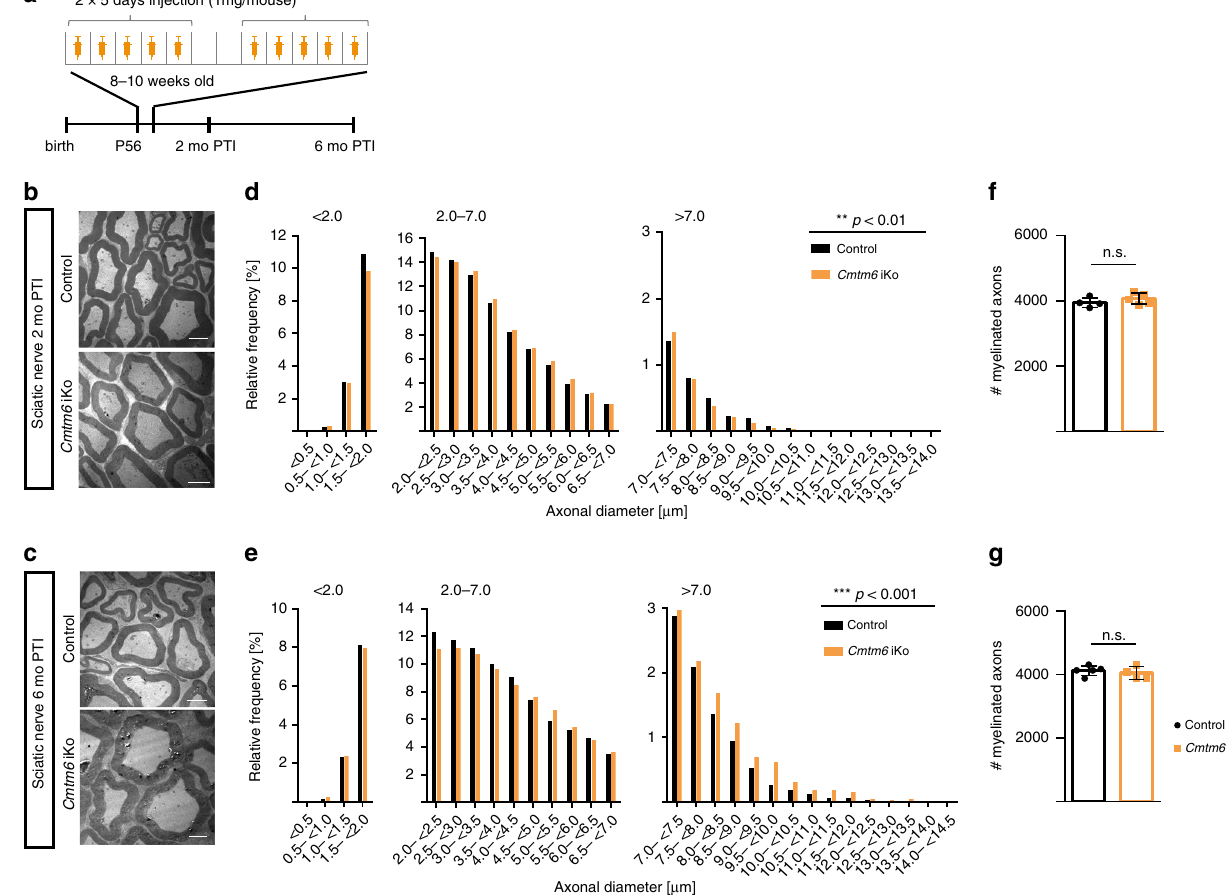
Fig. 4 Adult deletion of Cmtm6 causes increased axonal diameters. a Scheme for tamoxifen injection and time points post tamoxifen injection (PTI) for analyzing control mice (genotype Cmtm6 fl ox/ fl ox ) and Cmtm6 -iKo-mice (genotype Cmtm6 fl ox/ fl ox ; Plp CreERT 2 ). b , c Representative electron micrographs of cross-sectioned sciatic nerves show increased axonal diameters in Cmtm6 -iKo compared to control mice 2 mo PTI ( b ) and 6 mo PTI ( c ). Scale bar, 2.5 µ m. d , e Genotype-dependent quanti fi cation of diameters of myelinated axons in sciatic nerves dissected from Cmtm6 -iKo and control mice 2 mo PTI ( d ) or 6 mo PTI ( e ). Note the frequency shift toward increased axonal diameters in Cmtm6 -iKo-mice at both time points PTI. Data are presented as frequency distribution with 0.5 µ m bin width; ( d ) n = 14814 axons from n = 4 control mice and n = 20067 axons from n = 5 Cmtm6 -iKO mice; Mean axonal diameter (control + / − Cmtm6-iKo ) = 3.57 µ m + 0.03 µ m; P = 0.002 by two-sided Kolmogorow – Smirnow test; e n = 19,025 axons from n = 5 control mice and n = 15,047 axons from n = 4 Cmtm6 -iKO mice; mean axonal diameter (control + / − Cmtm6-iKo ) = 4.05 µ m + 0.17 µ m; P = 2.98e − 10 by two-sided Kolmogorow – Smirnow test of frequency distributions. f , g Quanti fi cations on semi-thin sections shows normal number of myelinated axons in Cmtm6 -iKo compared to control mice 2 mo PTI ( f ) and 6 mo PTI ( g ). f n = 4 control and n = 5 Cmtm6 -iKo mice, P = 0.2771 ( g ) n = 5 control and n = 4 Cmtm6 -iKo mice, P = 0.5394; by two-tailed Student ’ s t -test. Data in ( f ) and ( g ) presented as mean ± SD. n.s. = non-signi fi cant * P > 0.05; ** P < 0.01; *** P < 0.001. Source data see Source Data fi